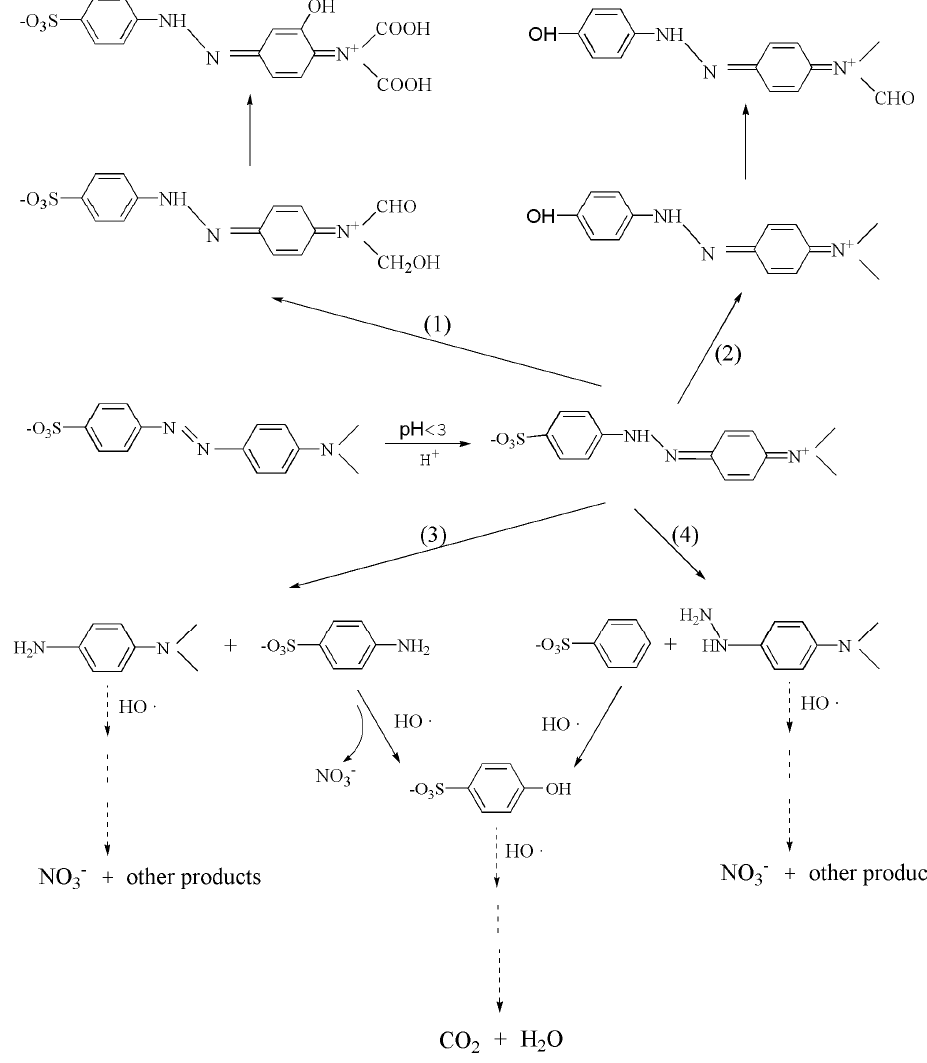
Figure 11. Speculation of possible degradation pathways of MO by Fe 2 O 3 /CNFs.